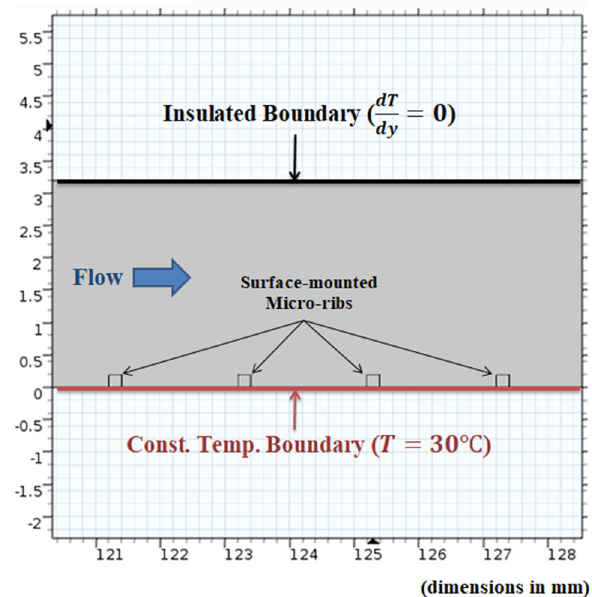
Fig. 3 CFD Simulation geometry for random data generation